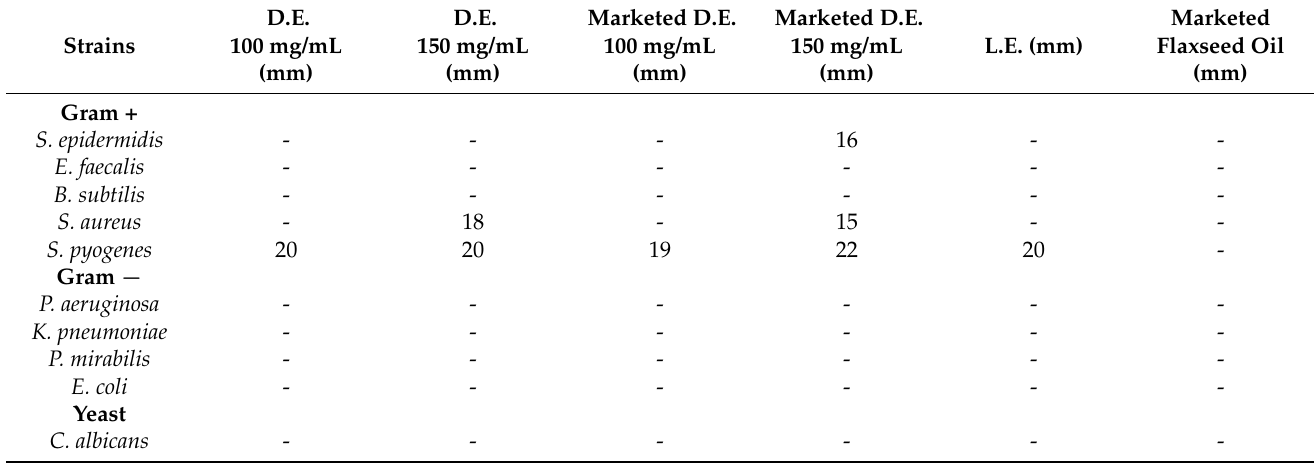
Table 3. Inhibition halos measured for D.E. and L.E. and for the commercial flaxseeds dry extract and oil.